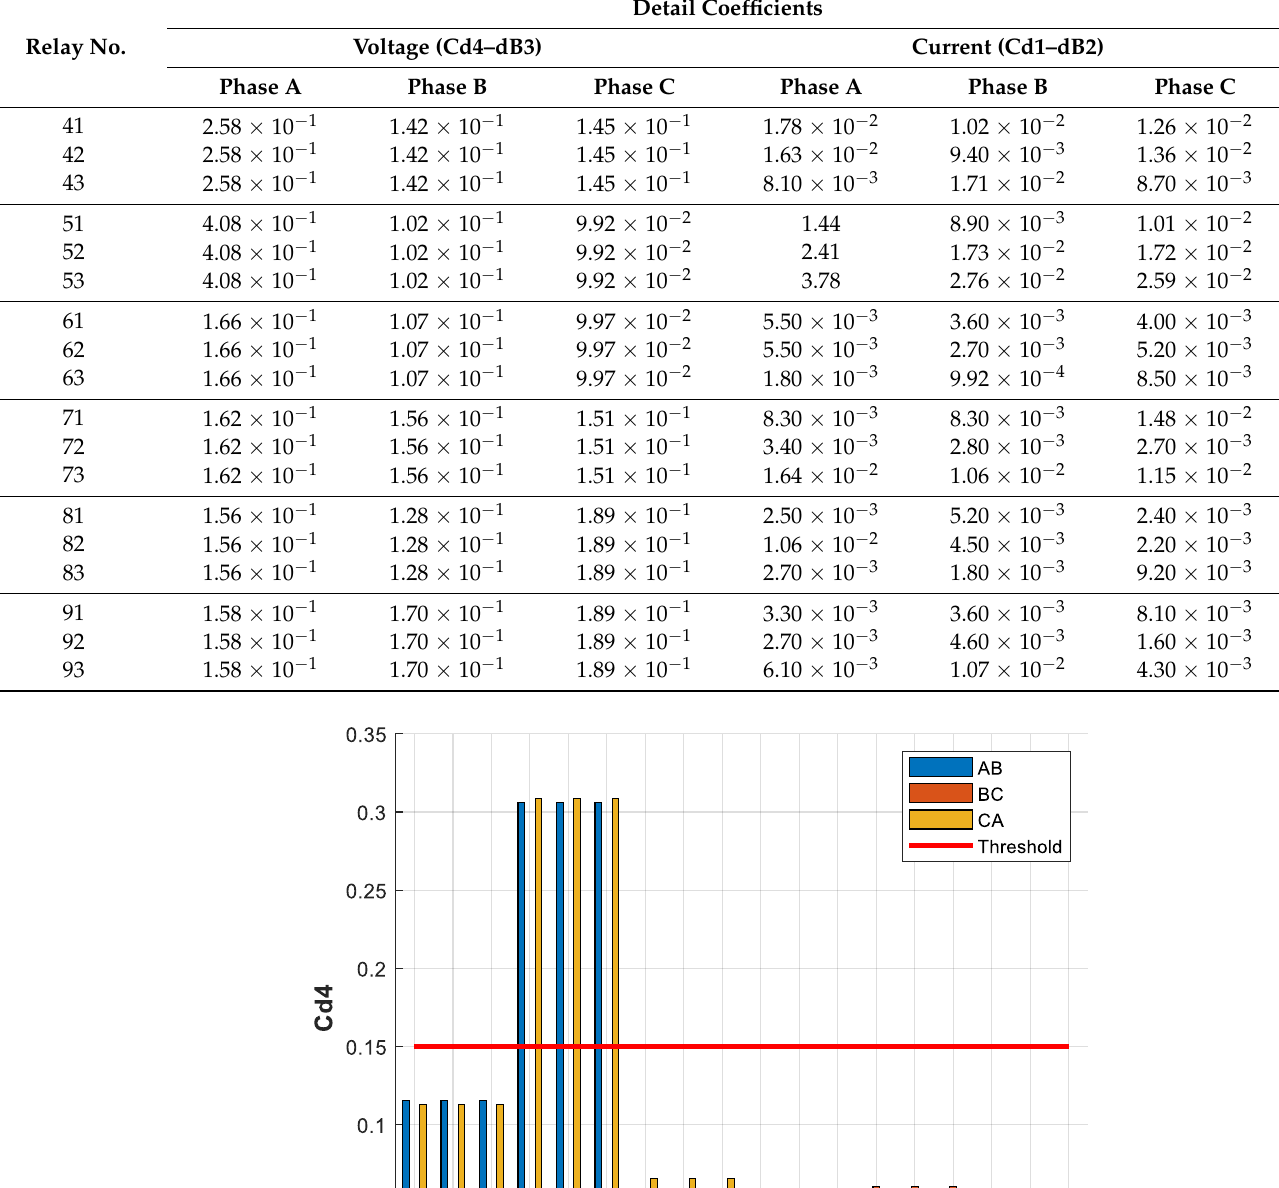
Table 2. Detail coefficients during phase-to-ground arc fault at load A.